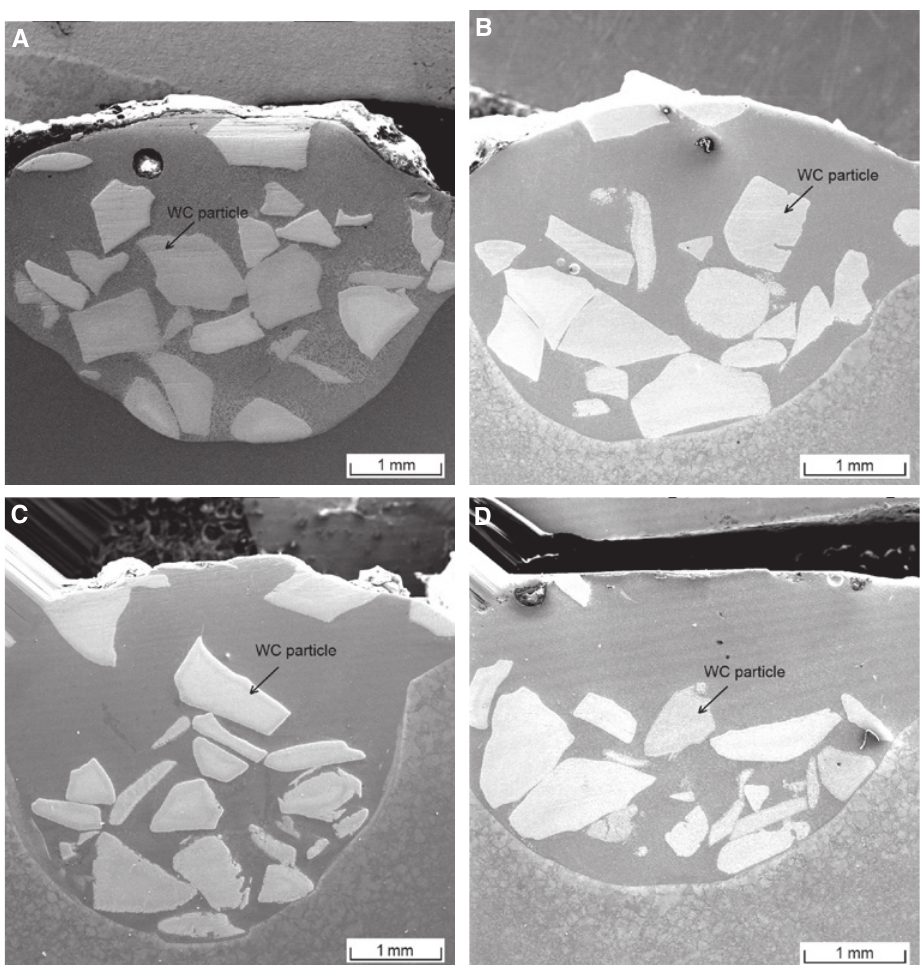
Figure 3: Cross-sections of the specimens prepared with different hopper heights: (A) H = 100 mm, (B) H = 200 mm, (C) H = 300 mm, and (D) H = 400 mm.